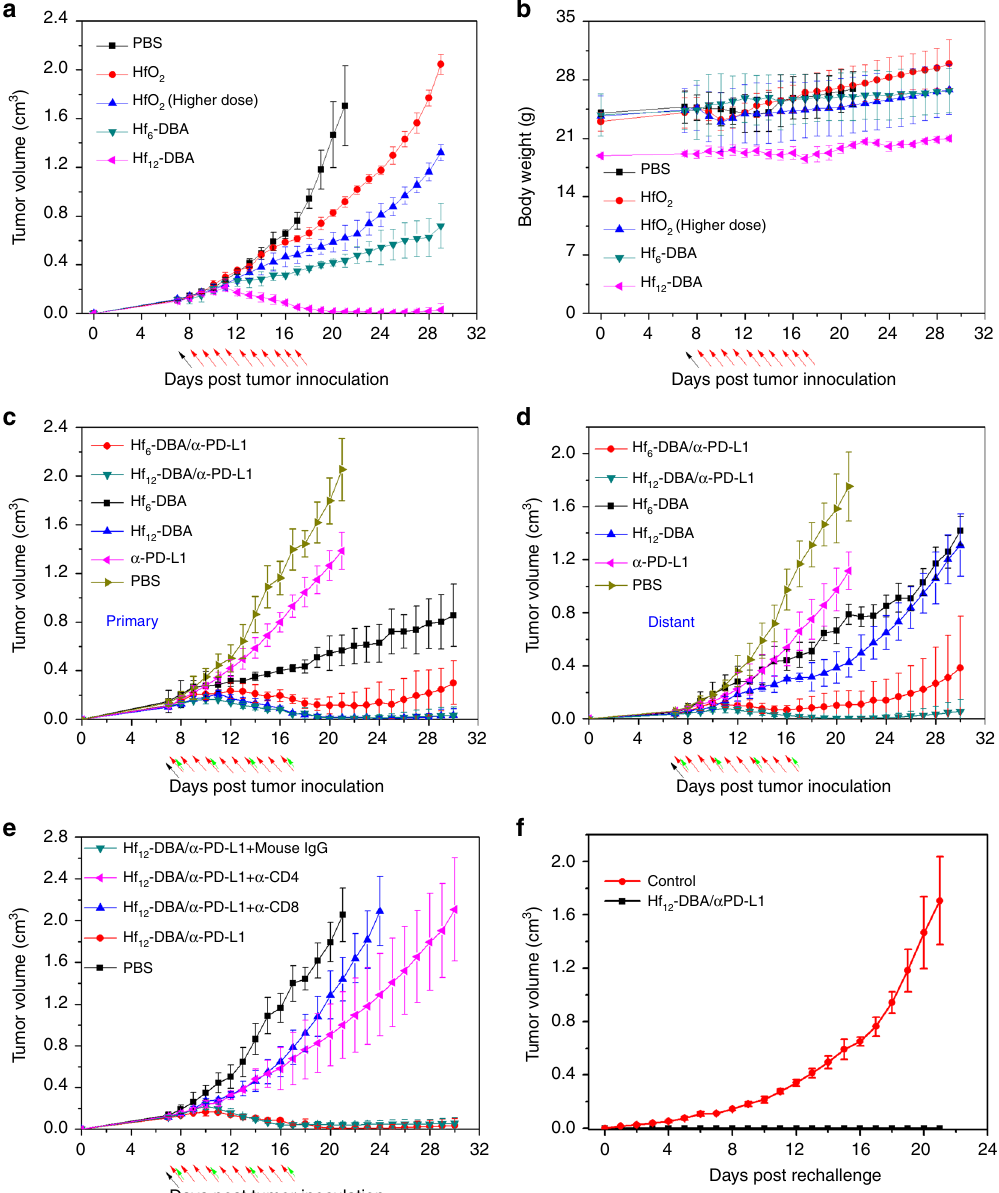
Fig. 4 In vivo studies comparing antitumor ef fi cacy of Hf-based NPs. Tumor growth inhibition curves ( a ) and body weights ( b ) after RT treatment in the single CT26 tumor-bearing mice treated with PBS, HfO 2 (low and high doses), Hf 6 -DBA, or Hf 12 -DBA. Tumor growth curves of c primary tumors and d distant tumors of CT26 bilateral tumor-bearing mice treated with Hf 6 -DBA (with or without anti-PD-L1 antibody), Hf 12 -DBA (with or without anti-PD-L1 antibody), anti-PD-L1 antibody, or PBS with X-rays irradiation. e Tumor growth curves of CT26 tumor-bearing mice with T cell depletion and treated with Hf 12 -DBA, anti-PD-L1 antibody, and X-ray irradiation. f Tumor growth curves after the tumor rechallenge with CT26 cells. Treatment began on day 7 after tumor inoculation when the tumor reached a volume of 100 – 150 mm 3 . X-ray irradiation was carried out on mice 12 h after the i.t. injection of PBS or NPs on 10 consecutive days at a dose of 1 Gy/fraction (120 kVp, 20 mA, 2 mm Cu fi lter). Antibody was given intraperitoneally every 3 days at a dose of 75 µ g/ mouse. Black, red, and green arrows refer to the times of PBS or nanoparticles injections, X-ray irradiation, and antibody administration, respectively. n = 6. P values for comparisons with controls by t test are indicated by three asterisks: *** P < 0.001. Central data points and error bars represent mean ± s.d. values, respectively. The Hf 12 -DBA with anti-PD-L1 treatment group was repeated